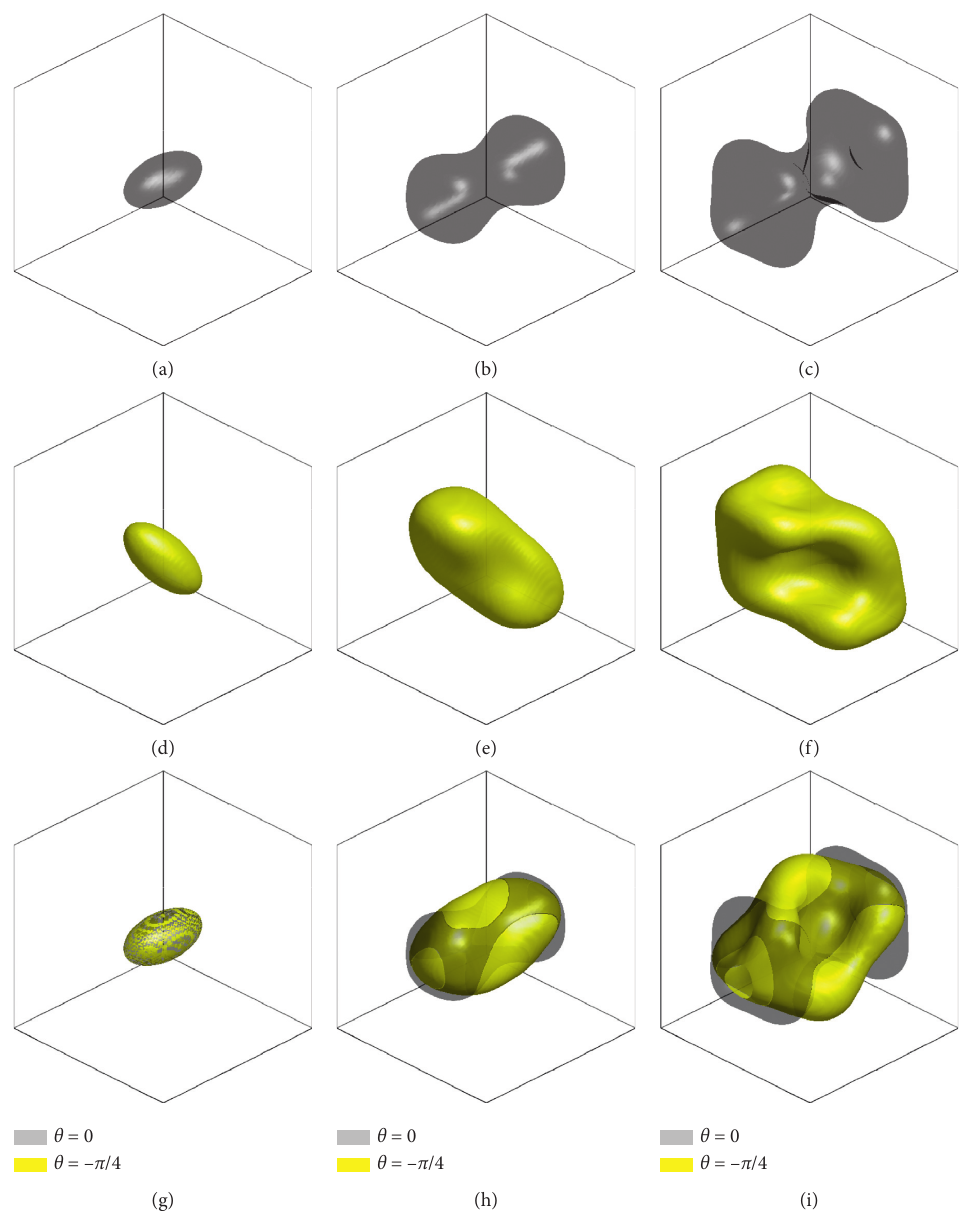
Figure 8: (a–c) Snapshots of isosurface ϕ � 0 for evolution in equation (9) using the standard scheme at t � 0, 600 Δ t , and 1000 Δ t , respectively. (d–f) Snapshots of isosurface ϕ � 0 for evolution in equation (10) using the standard scheme at t � 0, 600 Δ t , and 1000 Δ t , respectively. (g–i) Overlapped isosurfaces ϕ � 0 for each column at t � 0, 600 Δ t , and 1000 Δ t , respectively. Note that the axes are limited to show only (− 0 . 6 , 0 . 6 ) 3